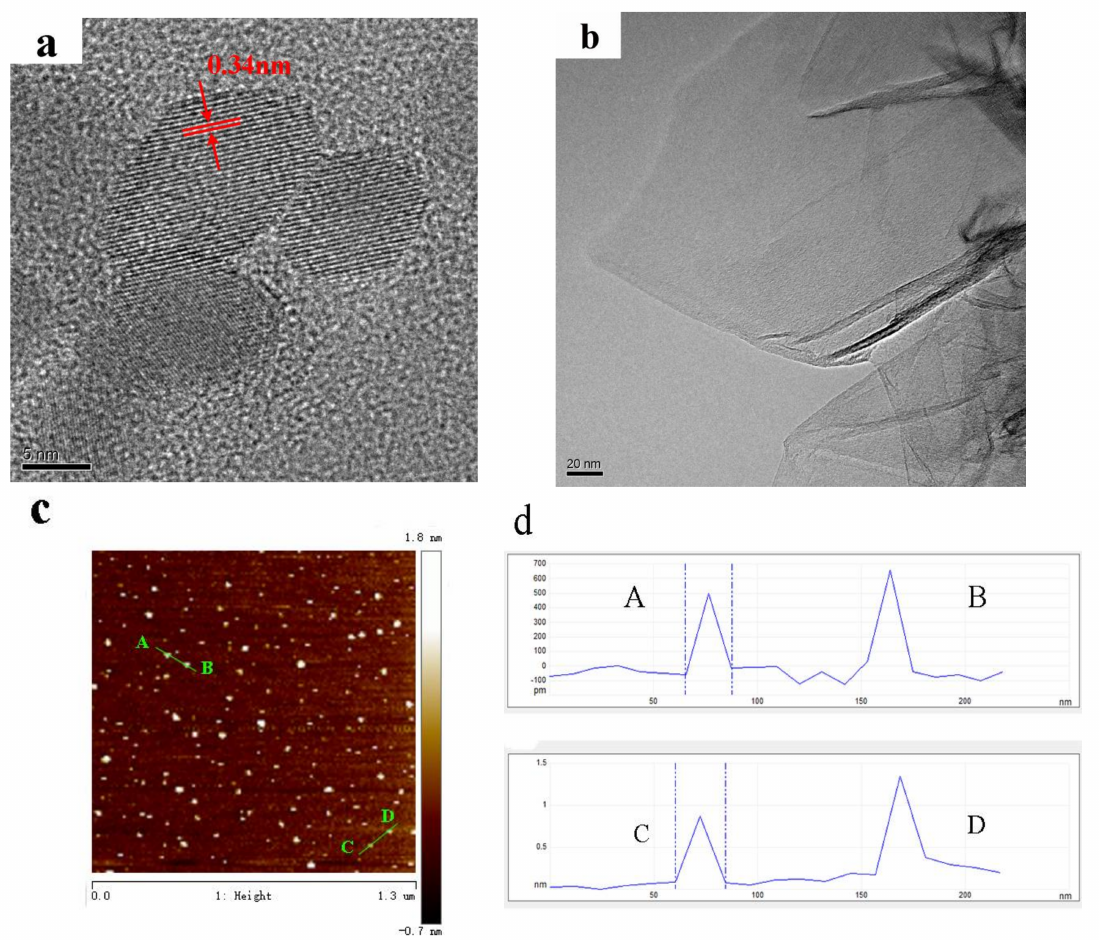
Figure 2. TEM image of graphene ( a ); HRTEM image of GQDs ( b ); AFM graph ( c ) of GQDs and height profile graph ( d ) of